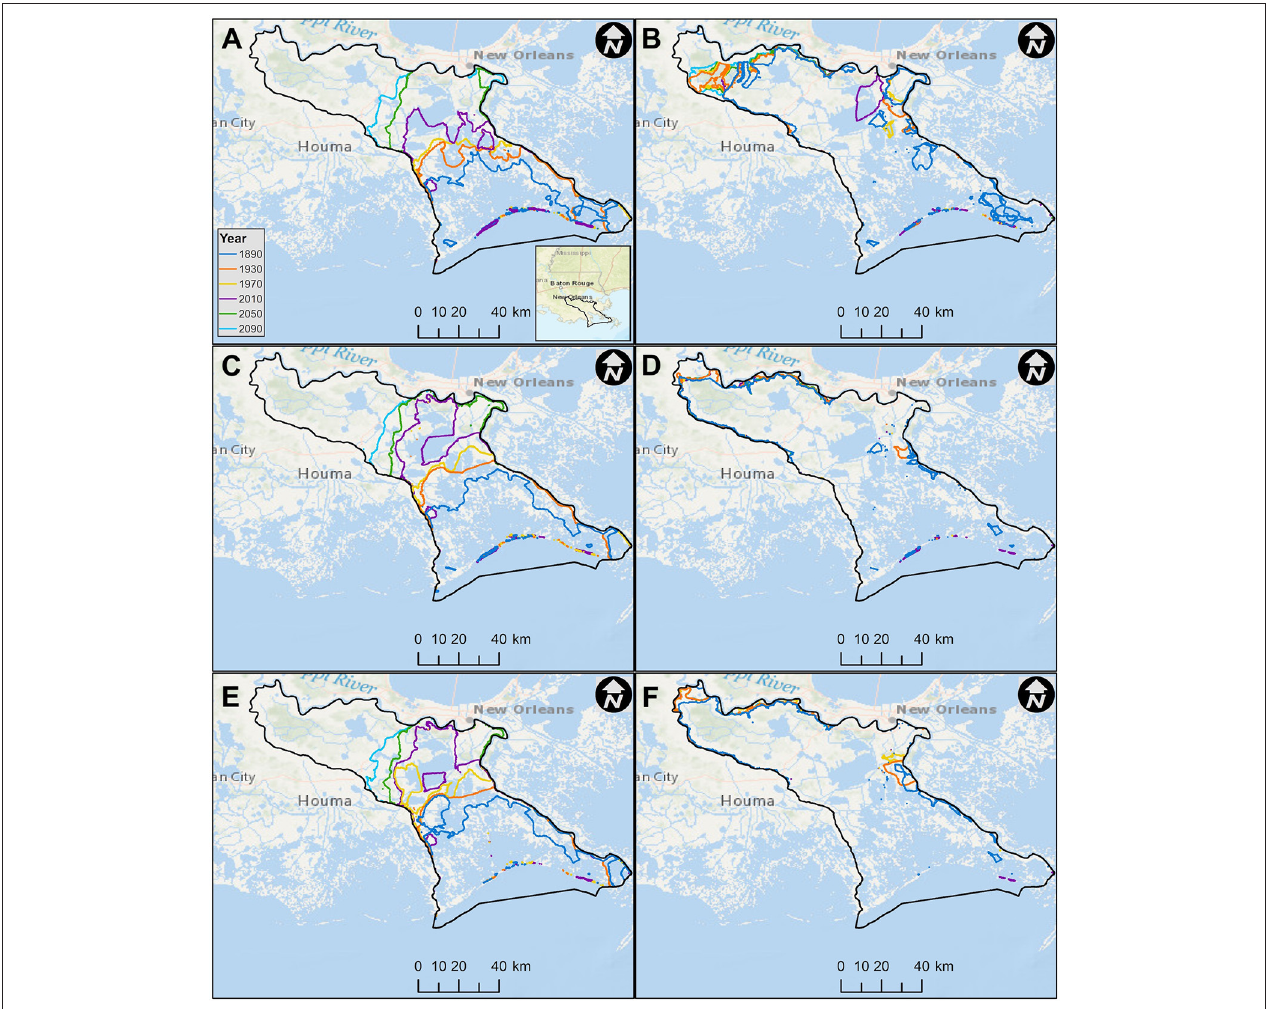
FIGURE 6 | Evolution of the (A,C,E) coastal and (B,D,F) hydrologic flood hazard zone extent for all years using the (A,B) low, (C,D) medium, and (E,F) high flood events at the Barataria watershed. Each color line represents a different era condition. Service Layer Credits: Esri, Garmin, GEBCO, NOAA NGDC, OpenStreetMap, and the GIS User